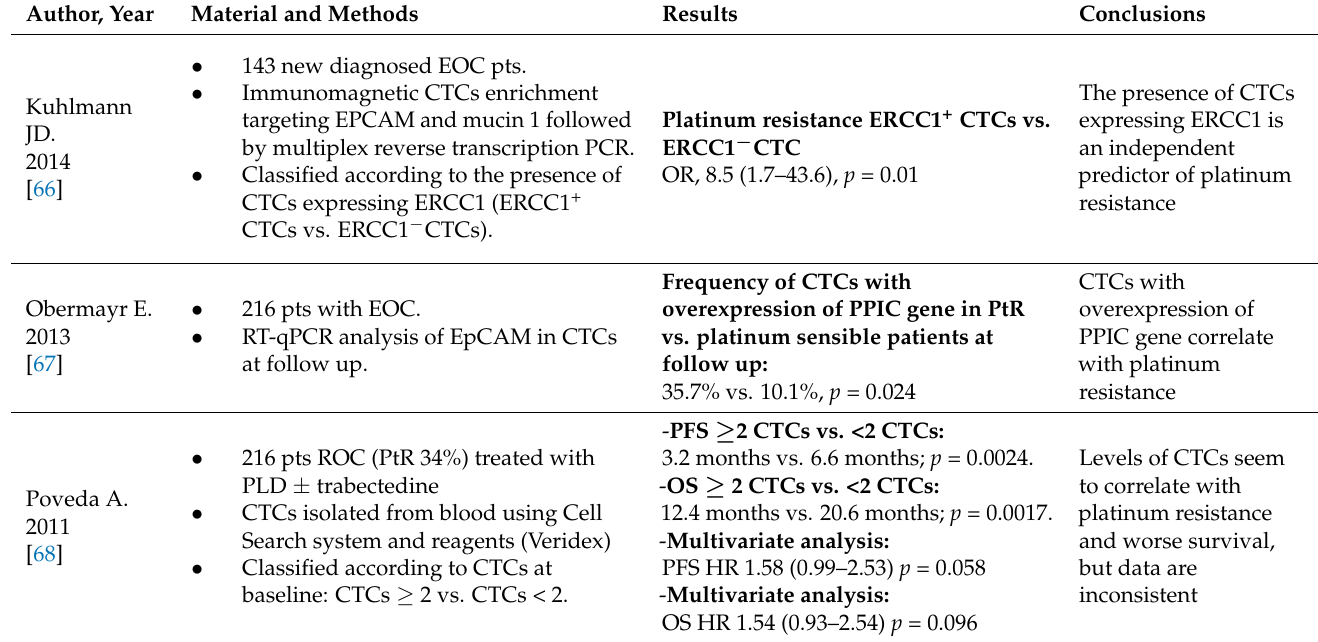
Table 3. Most relevant evidence about the role of CTCs in PtR